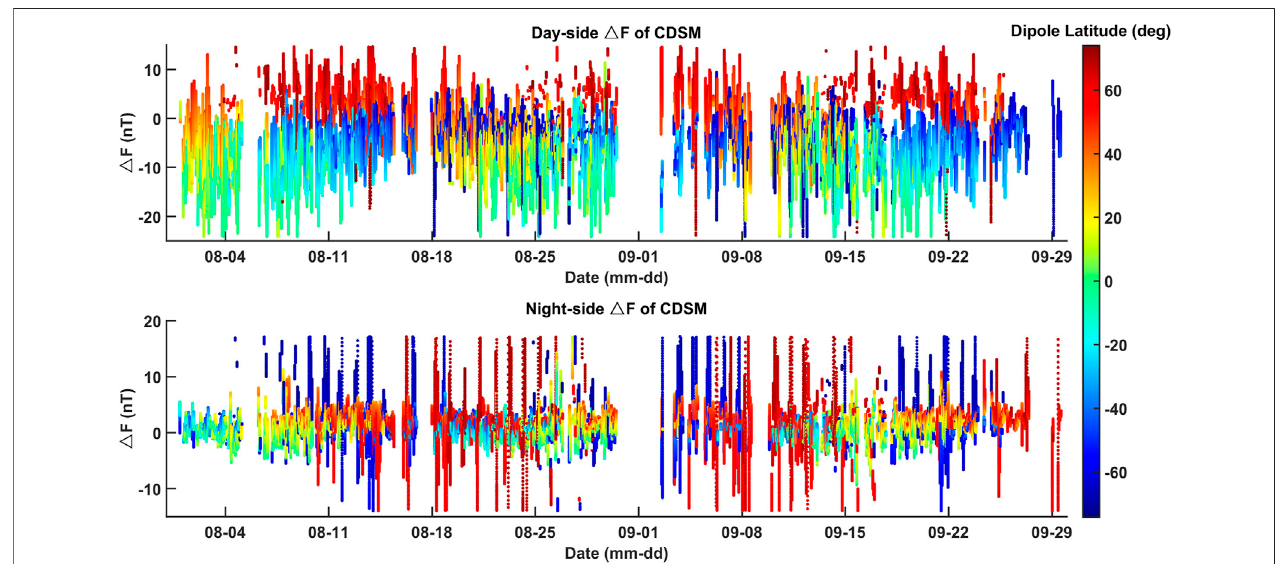
FIGURE 3 | Δ F of the CDSM from 31 July 2019 to 30 September 2019 (different colors represent the dipole latitudes of data points).